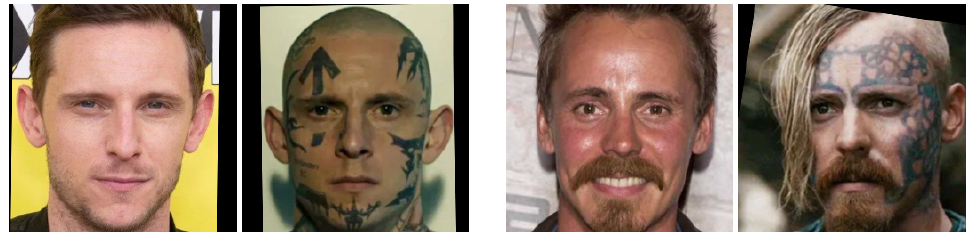
Figure 16. Examples of image pairs in the HDA facial tattoo and painting